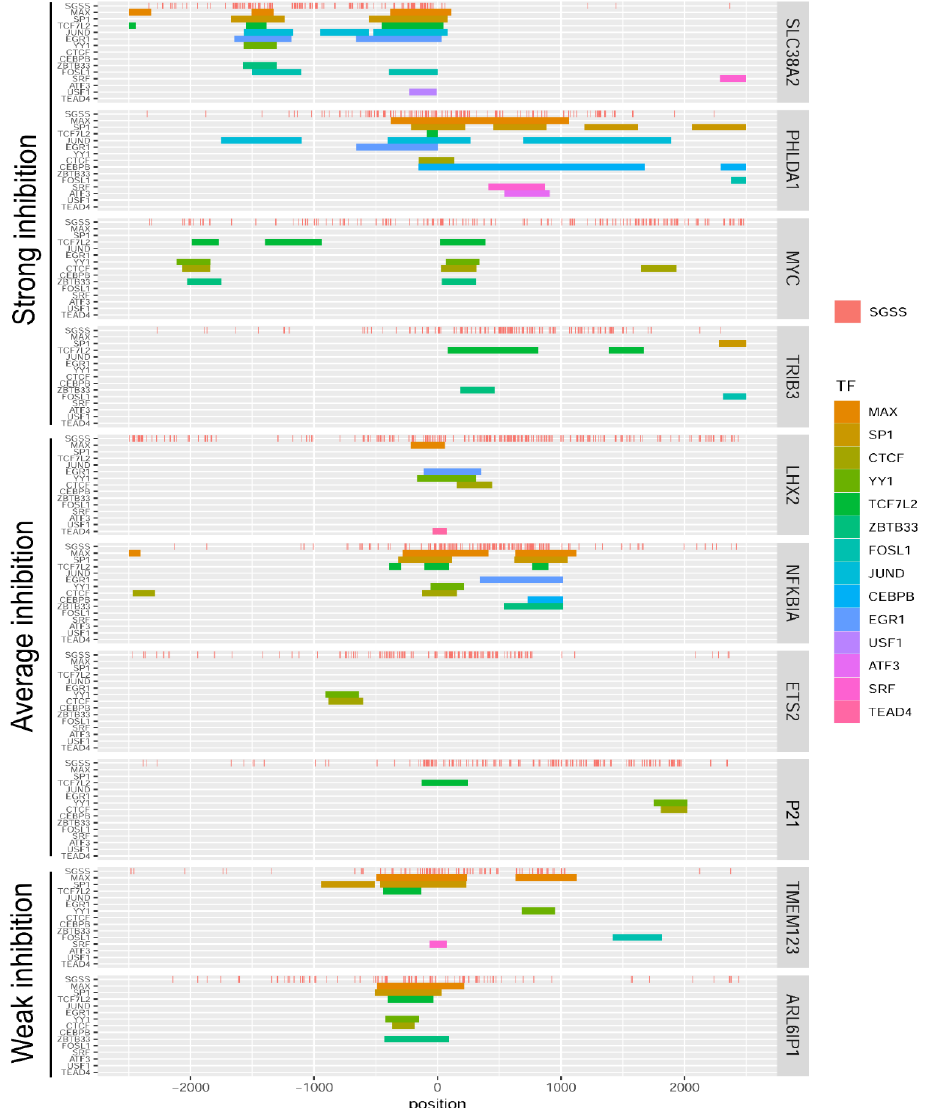
Figure 6. Mapping of GC tetrad distribution (SGSS, top red stripes in each gene block) and location of transcription-factor (TF) binding sites (colored). The analysis was based on the Encode database (see Section 3). Genes were grouped according to their transcriptional sensitivity to OA.